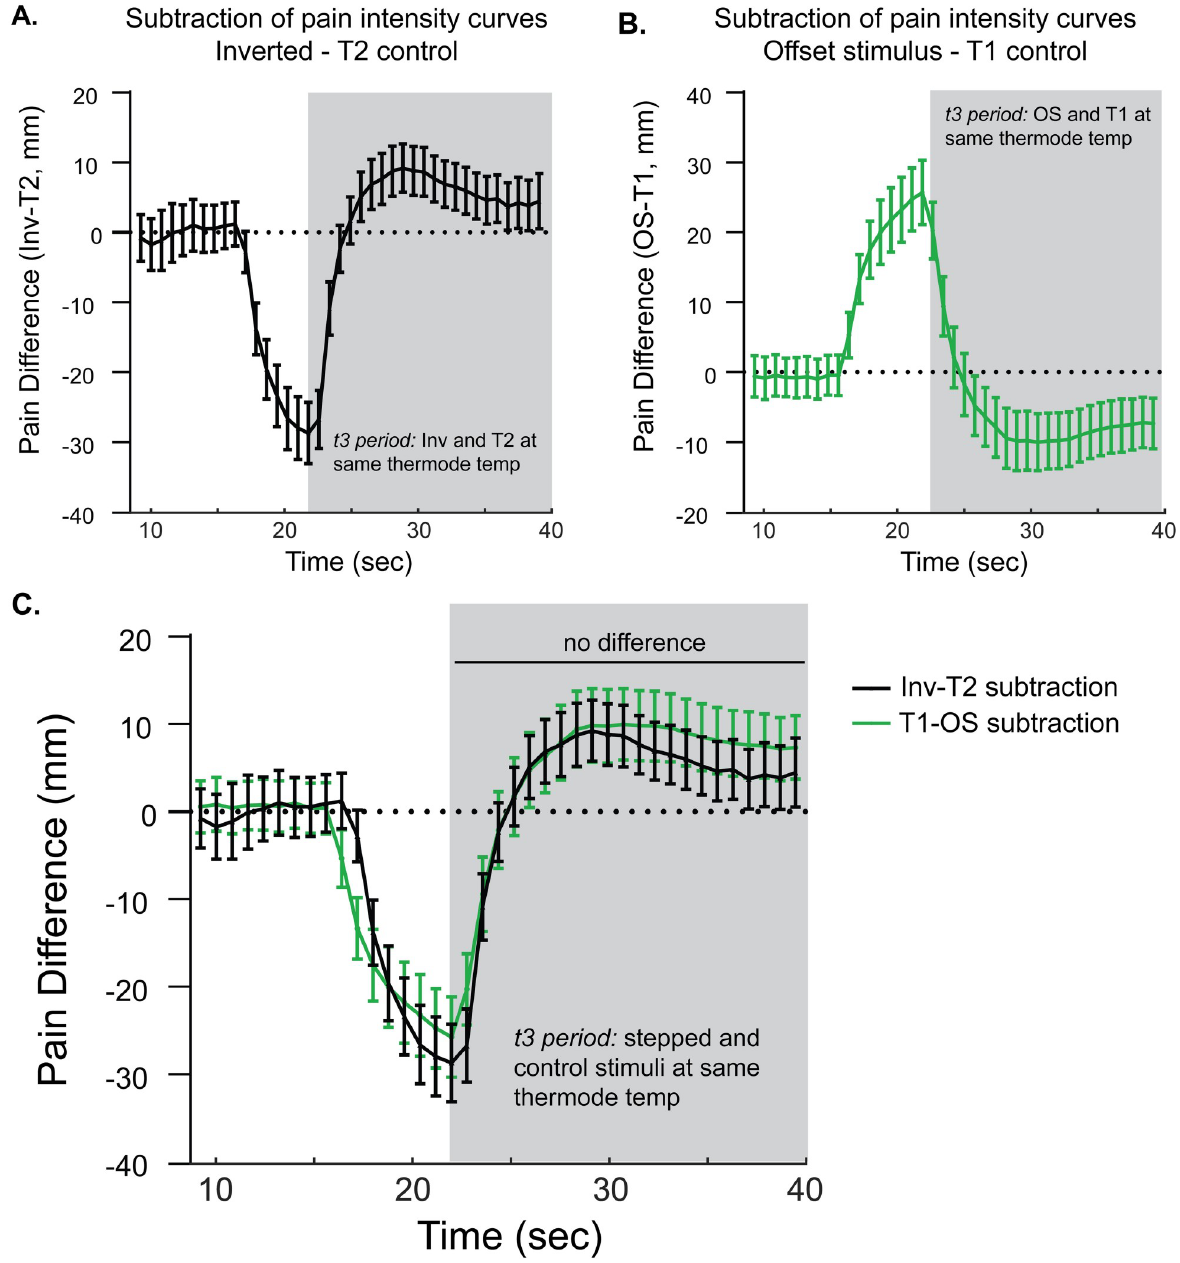
Fig 4. The absolute magnitude of relative hyperalgesia and hypoalgesia following equivalent temperature increases and decreases is similar. A. Pain intensity curves during Inv and T2 stimuli were subtracted for each subject with group mean values plotted; error bars = 95% CI. B. Similarly, pain intensity curves during OS and T1 stimuli were subtracted with group mean values plotted; error bars = 95% CI. In A. and B., shaded regions reflect the time period in which thermode temperatures are the same between stepped (Inv or OS) and constant (T2 or T1) stimuli. C. To compare pain difference curves, the inverse of the OS-T1 subtraction curve in B. was plotted with the Inv-T2 subtraction curve. Means and 95% CI are shown at each timepoint. In Fig 5A, the absolute magnitude of the difference between stepped stimulus extrema (mini- mum for OS and maximum for Inv) and the equivalent timepoint in the constant control stim- ulus (T1 for OS and T2 for Inv; Fig 1, “a” arrows) was averaged across the group and plotted with 95% confidence intervals. A paired t-test shows no significant difference between these